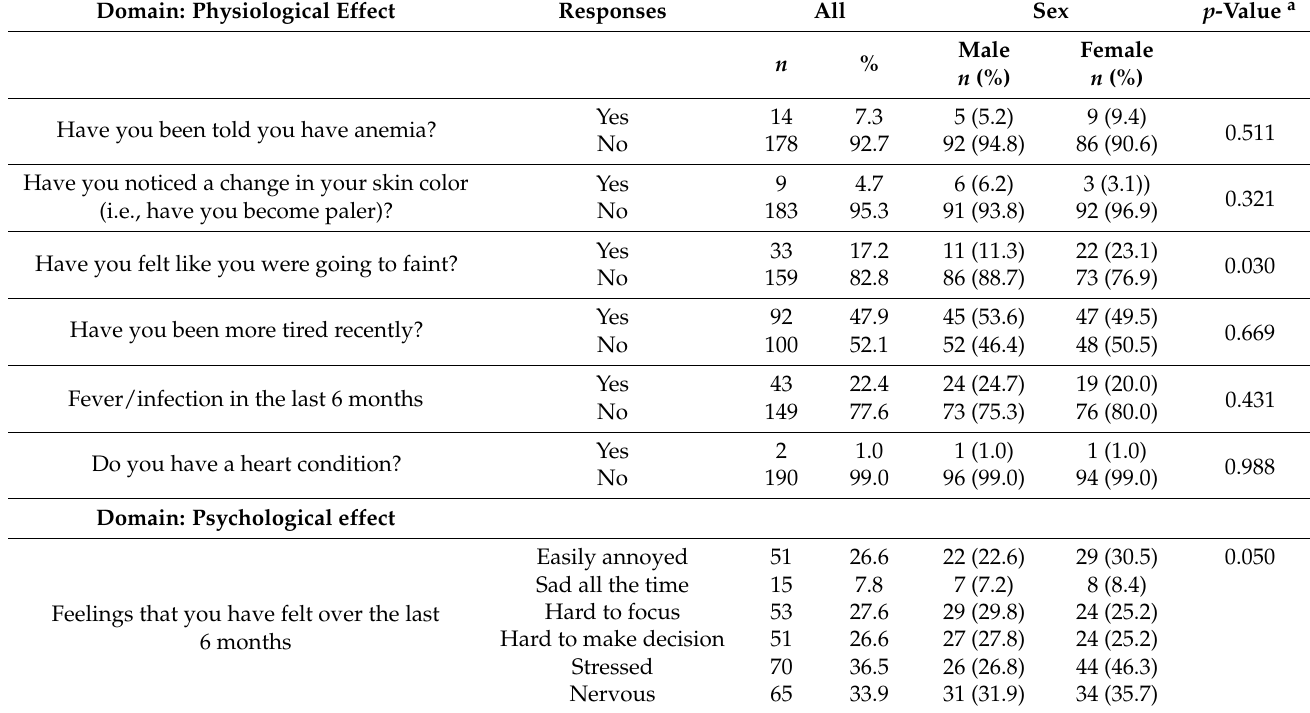
Table 5. Responses on physiological and psychological